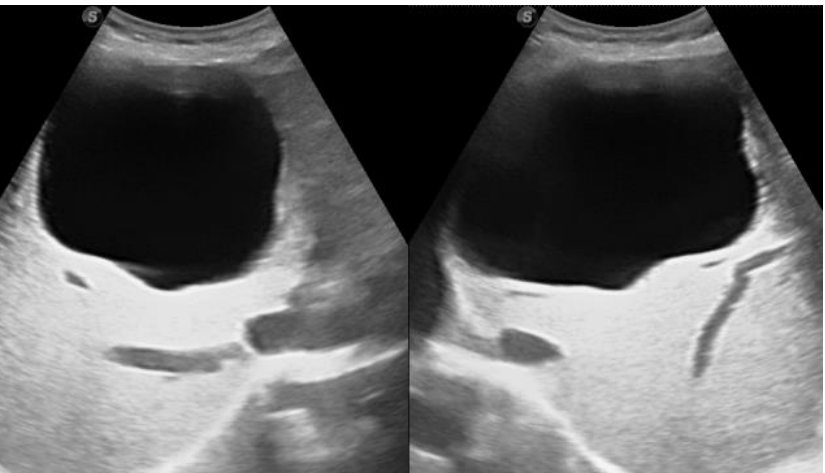
Figure 4. Ultrasound images of a 35-year-old female showing a well-circumscribed, unilocular, anechoic cystic lesion measuring about 10 cm with no internal septation or solid component centered in segment IV of the right hepatic lobe, exerting slight compression on the gallbladder with no remarkable biliary dilatation or frank calcifications. Picture is in keeping with hydatid cyst stage CE1 (WHO classification).